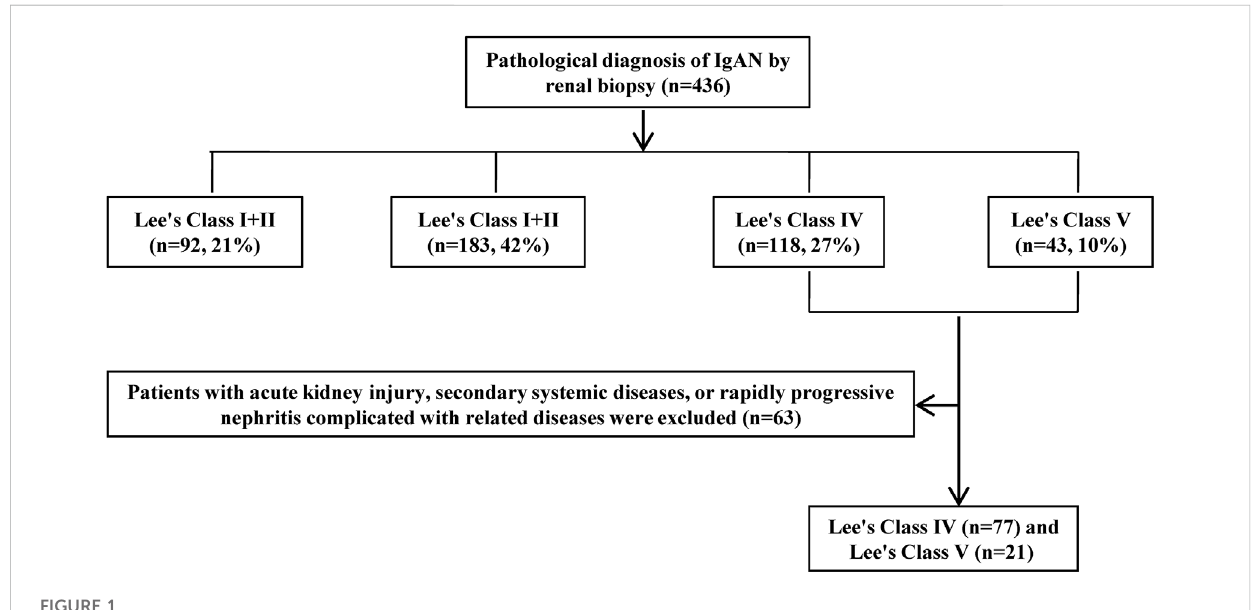
FIGURE 1 Flow – chart of enrollment and